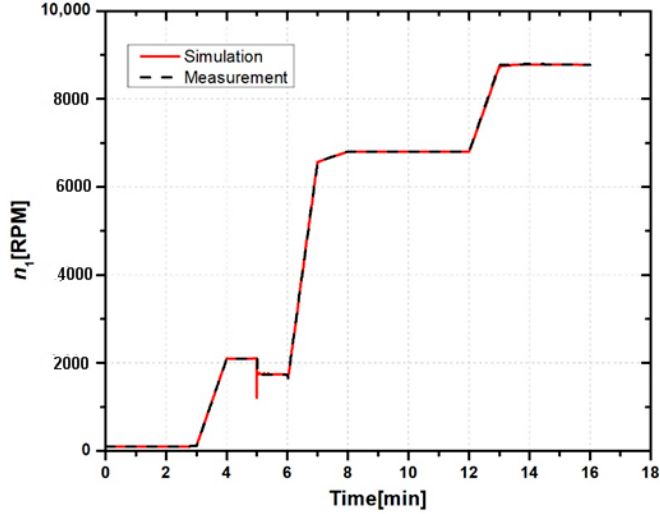
Figure 6. Comparison of simulation results and measuring data for high-pressure turbine rotational speed .